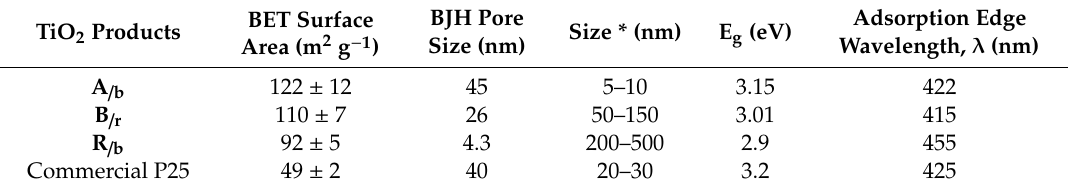
Table 2. Phase composition and properties of synthesized mixed-phase nanoTiO 2 products; BET surface area, BJH pore size, estimated band gap energy, E g , nanoparticle diameter as determined from TEM images.